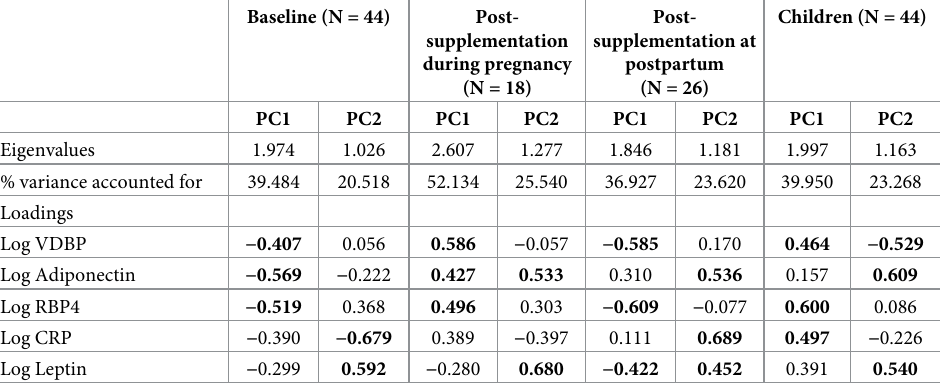
Table 3. Principal component analysis of biomarkers for maternal baseline, maternal follow-up, and for children.